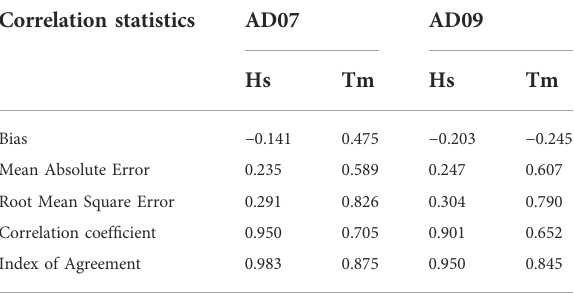
TABLE 1 Correlation statistics between simulated data and Observed buoy